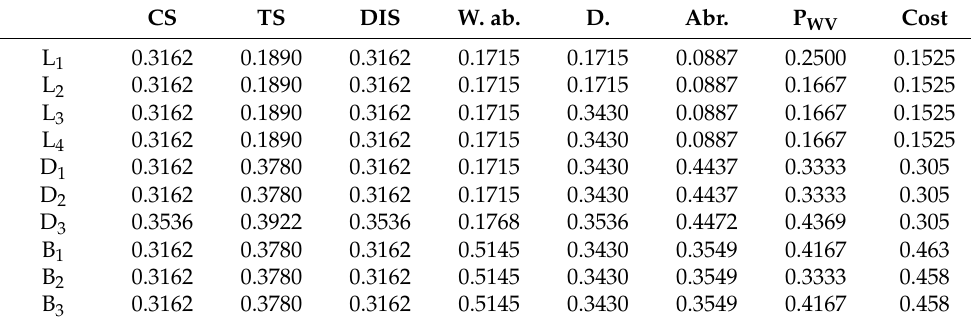
Table 6. Normalized matrix.